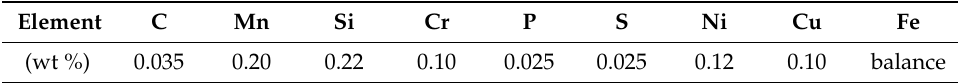
Table 1. The nominal composition of Armco